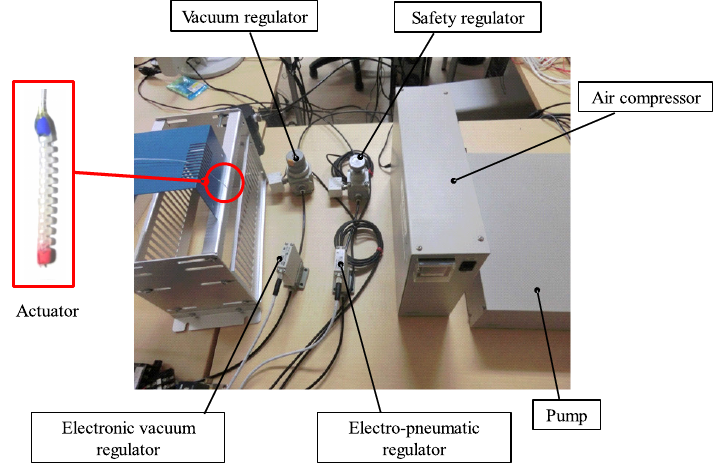
Figure 9. Experimental